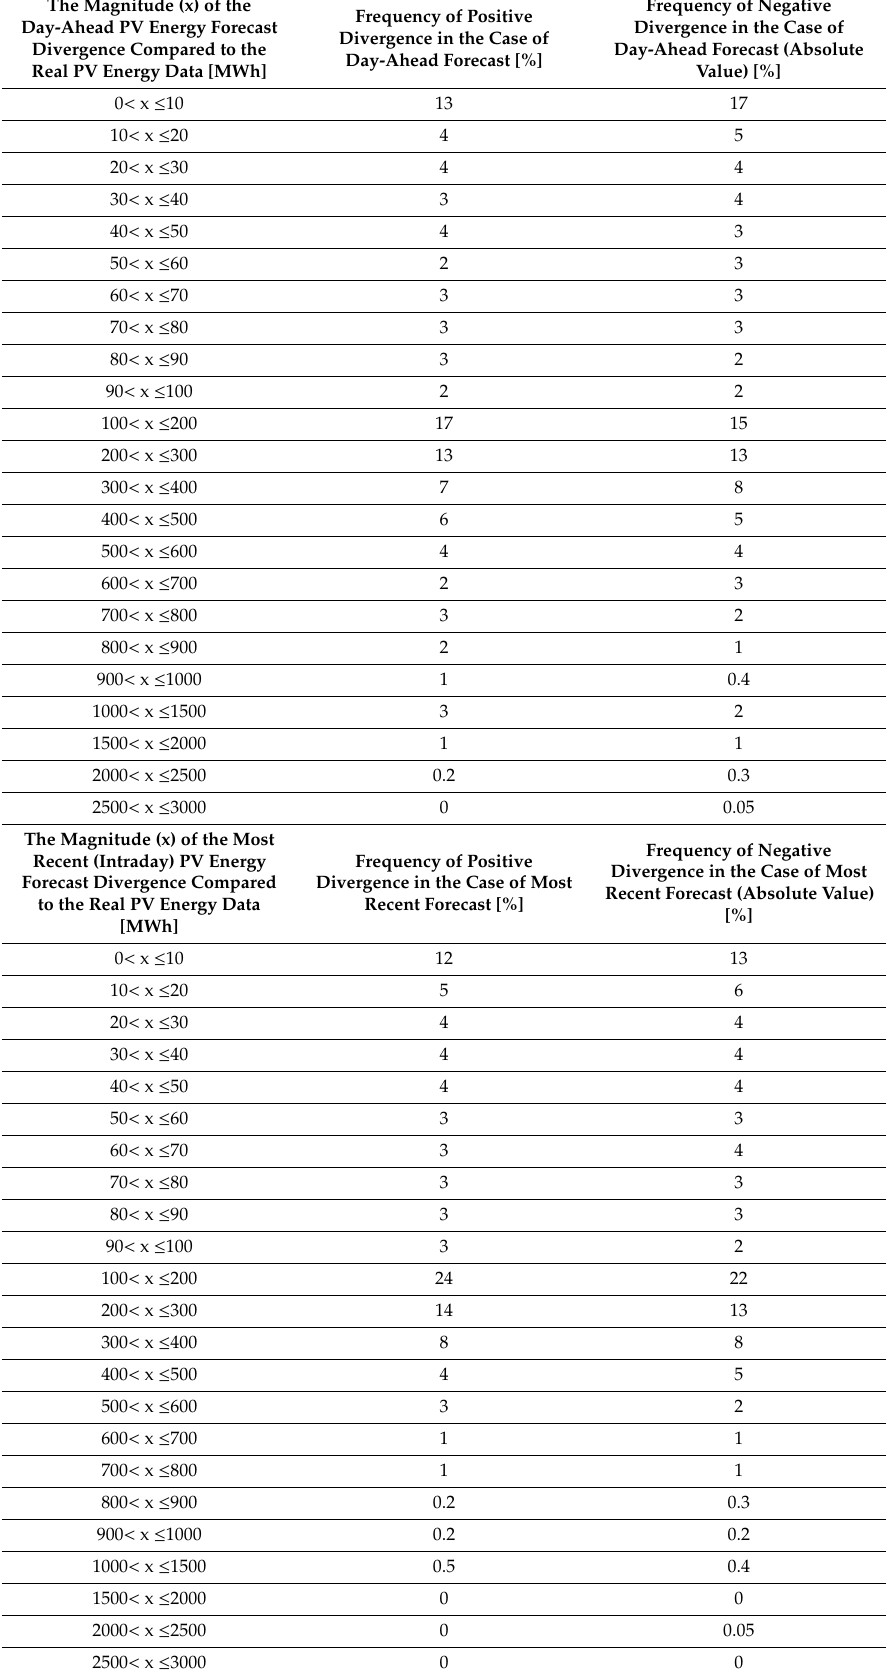
Table 5. The magnitude of the day-ahead / intraday PV energy forecast divergence (24 h based) compared to the real PV energy data for the period of 30 / 09 / 2014–30 / 09 /